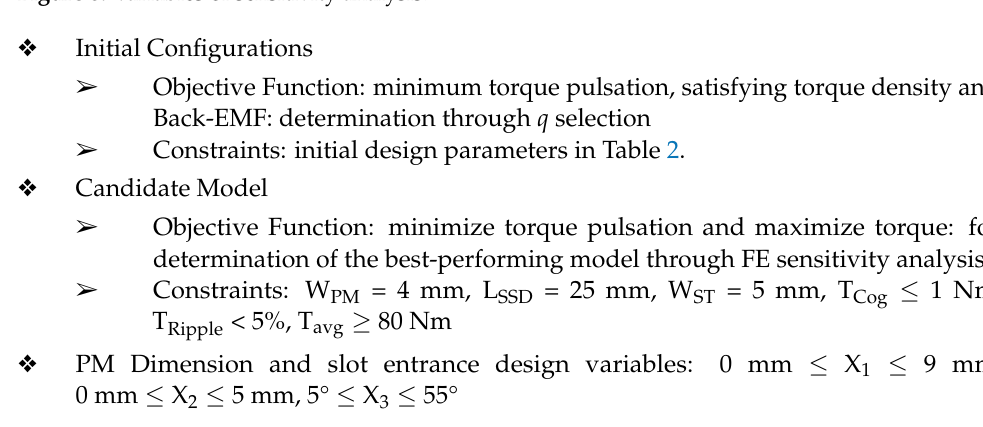
Figure 8. Variables of sensitivity analysis.